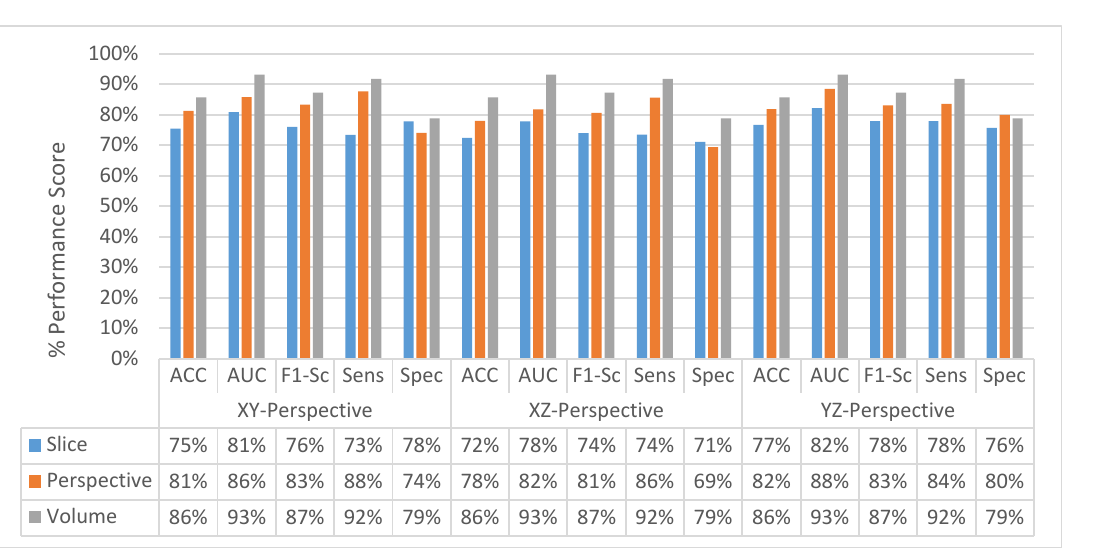
Figure 25. SFMPF model using Gabor image—change in classification performance for slice, perspective, and volume-level classifications for each perspective.